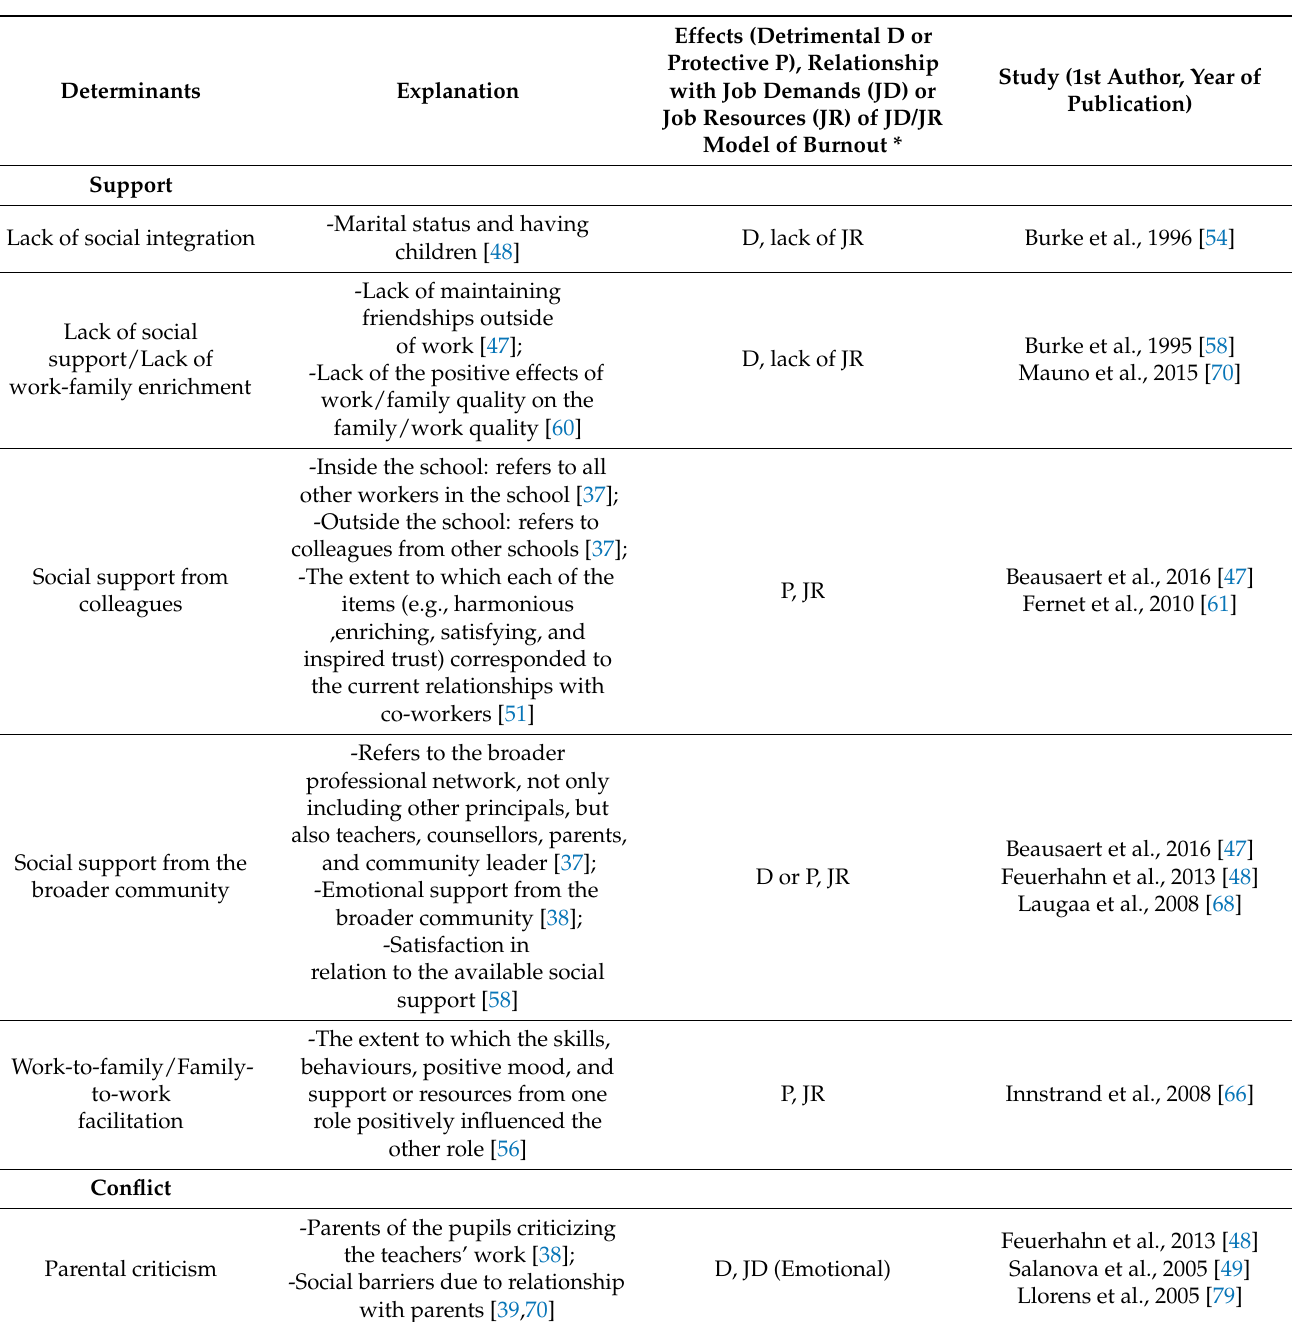
Table 2. List of burnout determinants detected within the qualitative